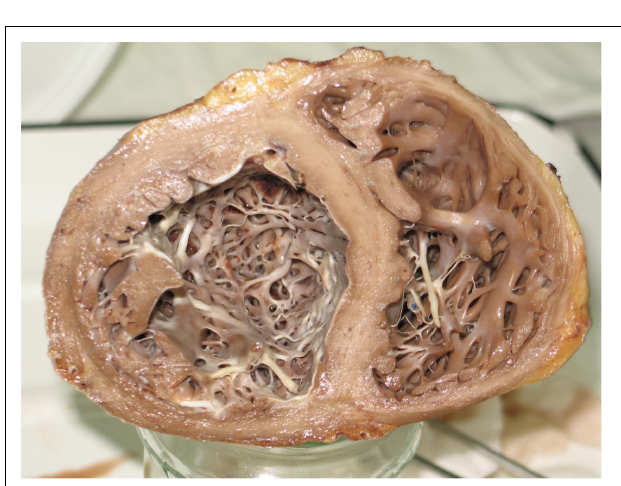
FIGURE 4 | Explanted heart of a patient with early and durable response to STereotactic Arrhythmia